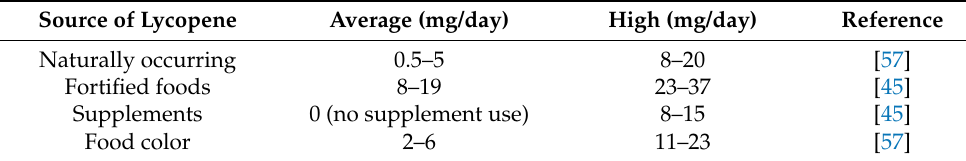
Table 2. Average dietary exposure to lycopene from all